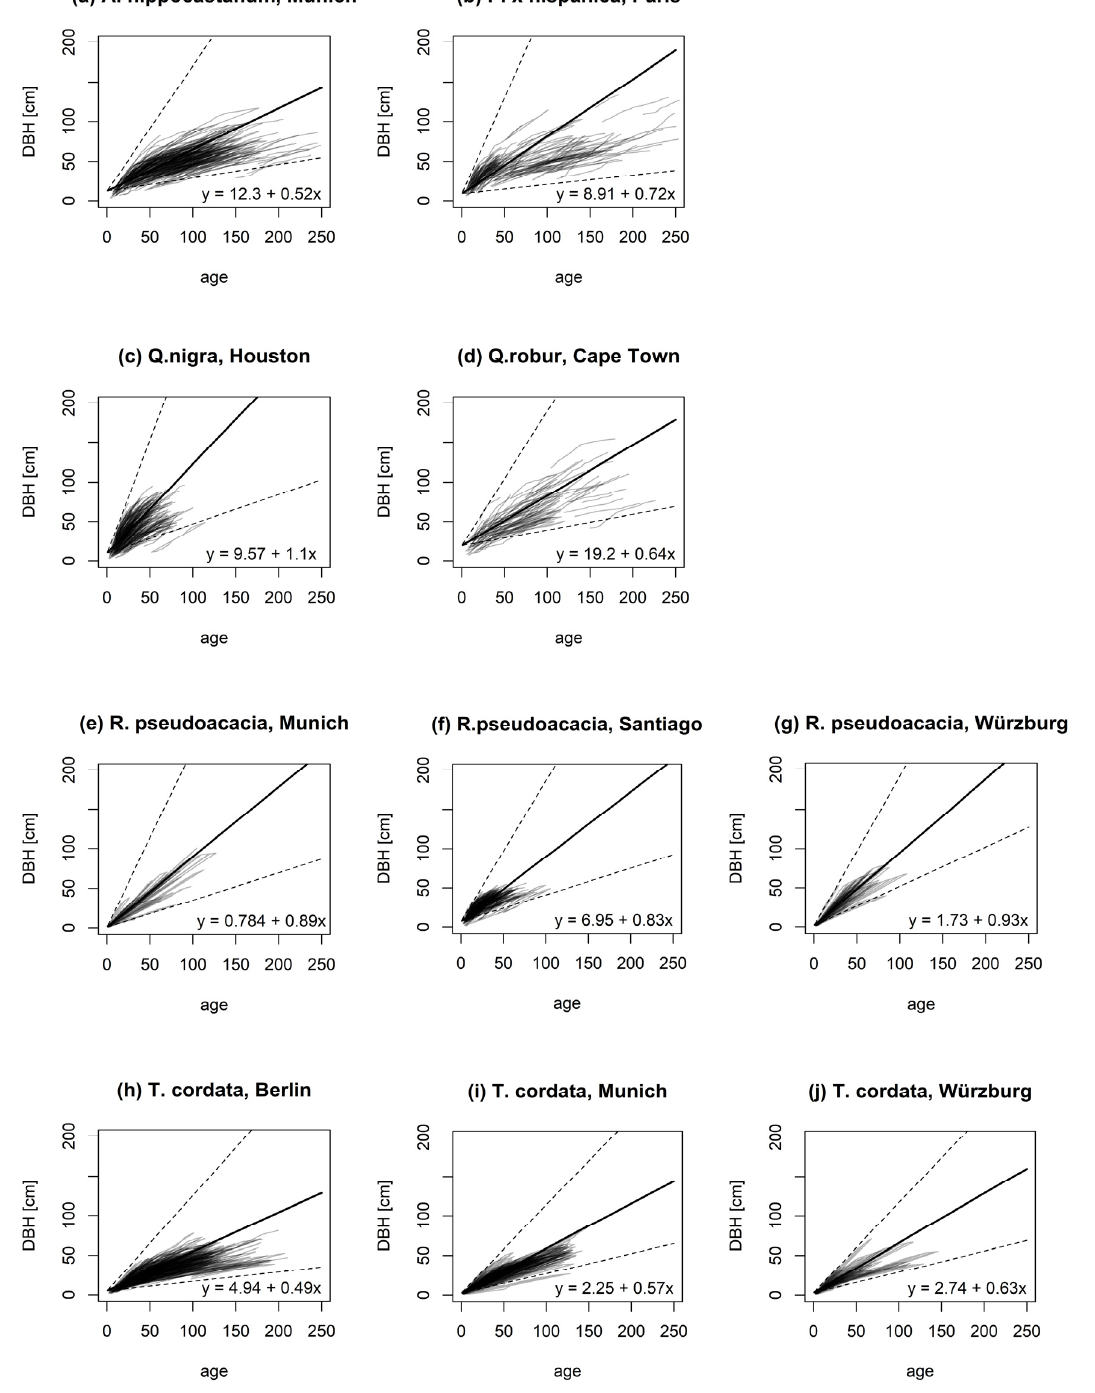
Figure 1. Diameter-age relationship for the tree species Aesculus hippocastanum L. in Munich ( a ); Platanus × hispanica Münchh. in Paris ( b ); Quercus nigra L. in Houston ( c ); Quercus robur L. in Cape Town ( d ); Robinia pseudoacacia L. in Santiago de Chile ( e ), Munich ( f ), and Würzburg ( g ); and Tilia cordata Mill. in Berlin ( h ), Munich ( i ), and Würzburg ( j ). The solid line represents the mean stem diameter growth, while the dashed lines show the minimum and maximum.